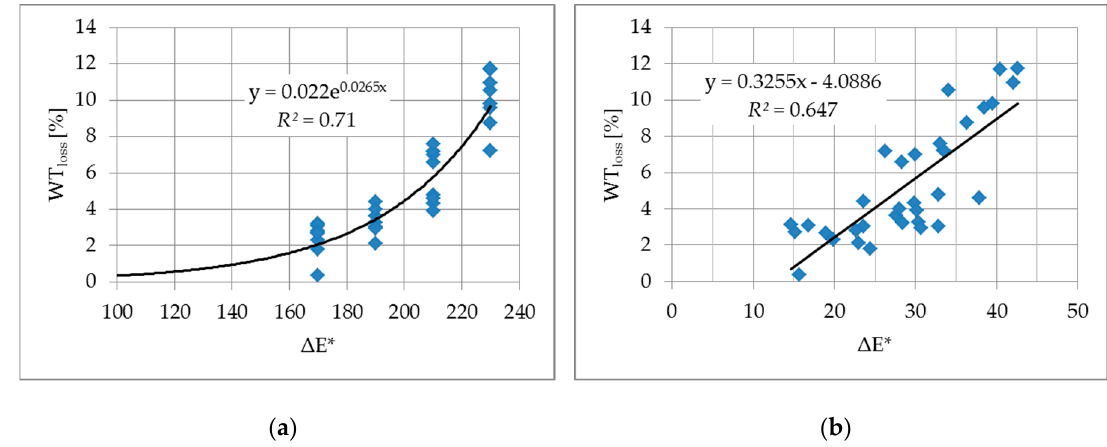
Figure 2. ( a ) The relationship between the individual weight loss (WT loss ) of wood and the intensity of the heat treatment; ( b ) the relationship between the individual weight loss (WT loss ) of wood and its total color difference ( Δ E*).